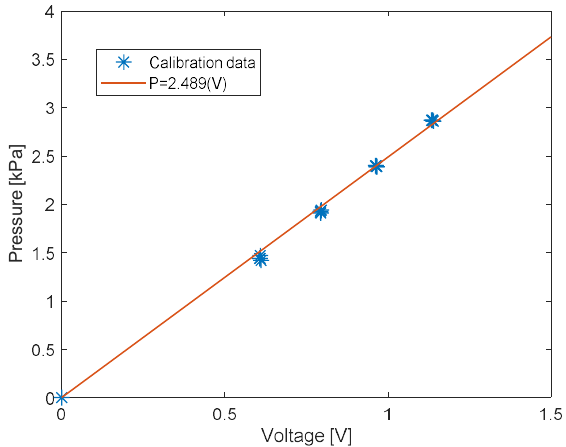
Figure 4. Calibration results with linear fitting.